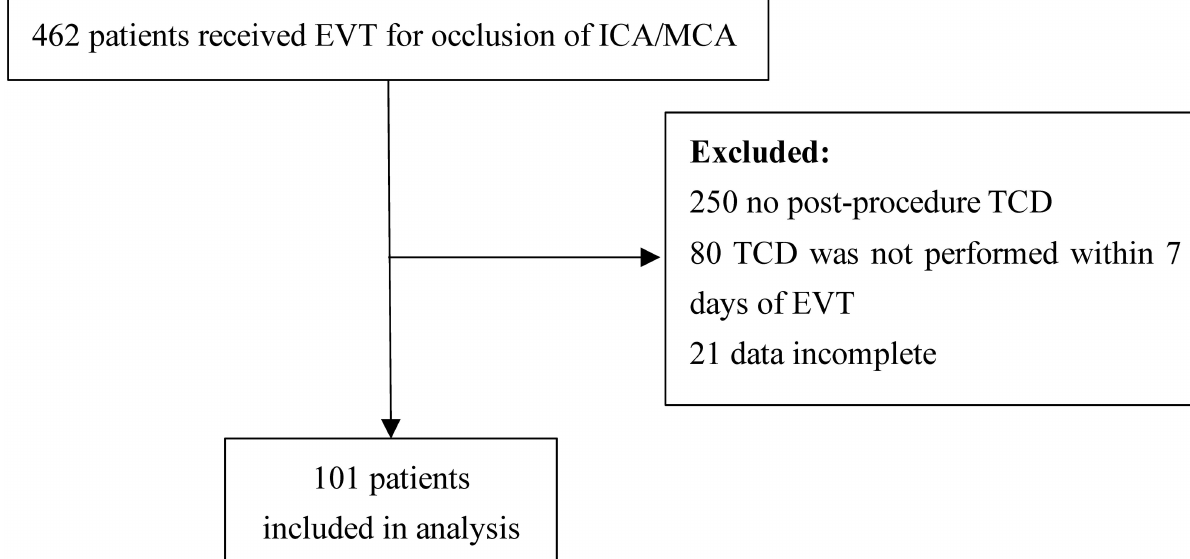
FIGURE 2 | Flow diagram of patient inclusion for the study. EVT, endovascular therapy; ICA, internal carotid artery; MCA, middle cerebral artery; TCD, transcranial Doppler.